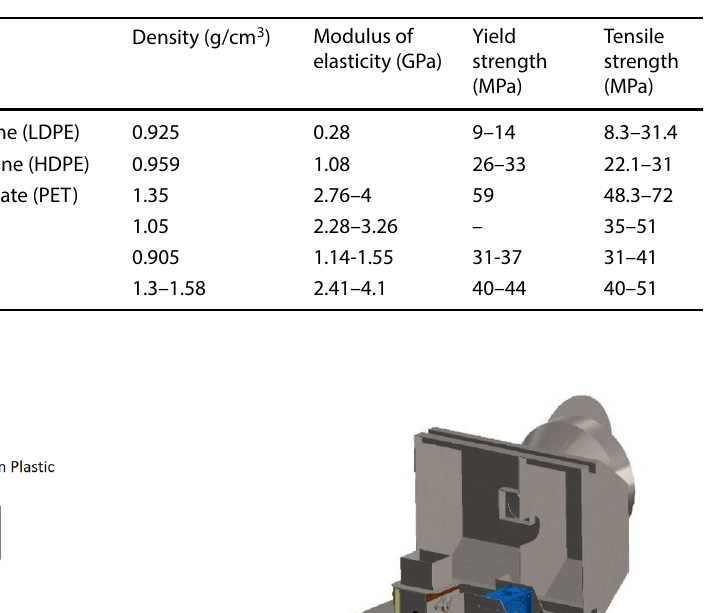
Fig. 3 Flow of the overall recycling system